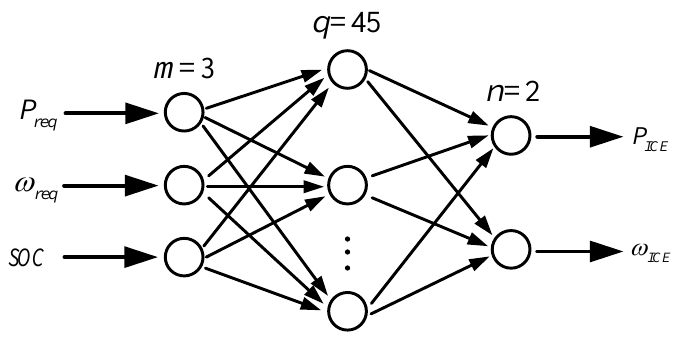
Figure 10. BP neural network energy management controller structure diagram.